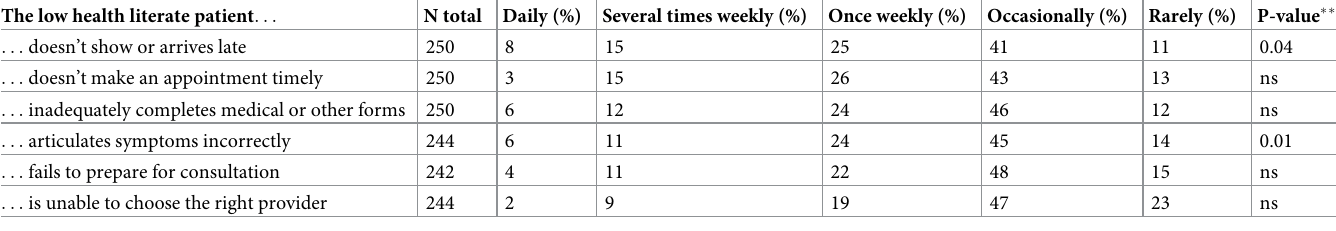
Table 3. Frequencies in which healthcare providers encountered challenges with low health literate patients prior to a consultation � . The low health literate patient ...